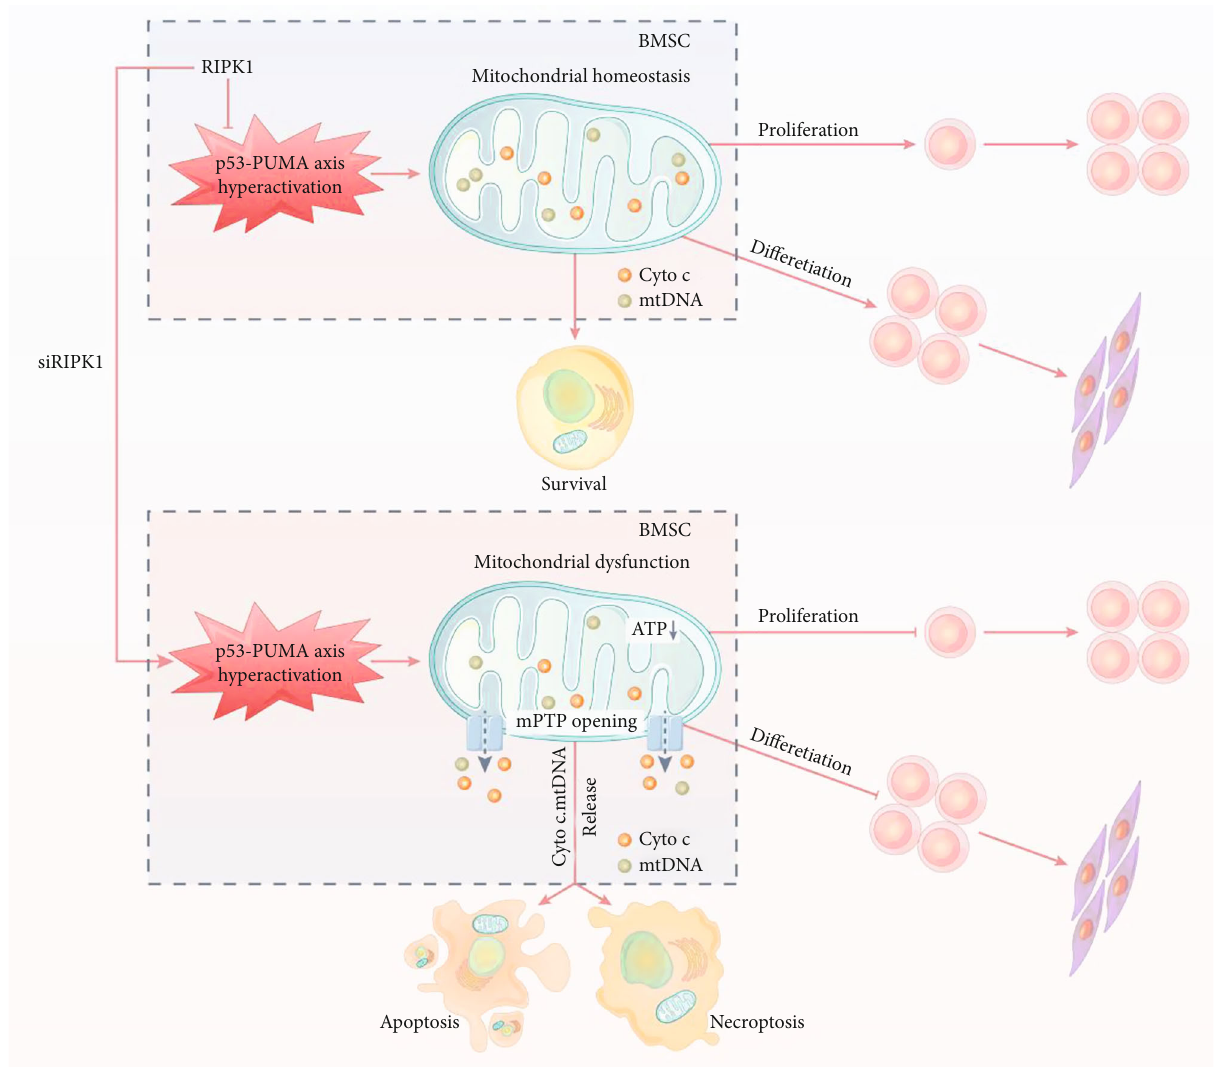
Figure 7: Schematic illustration showing that p53-PUMA-mediated mPTP is involved in RIPK1 de fi ciency-induced apoptosis and necroptosis of bone marrow